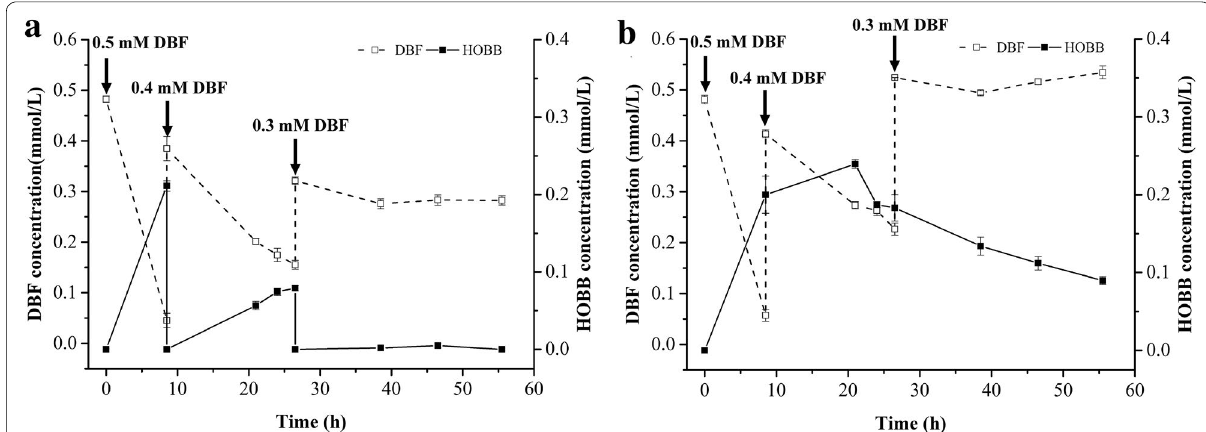
Fig. 5 Biosyntheses of HOBB in batch and fed-batch processes. DBF degradation (open square) and HOBB accumulation (closed square) were evaluated in the two groups. a For the batch group, the biocatalysts were recycled twice, so that there were three sequential batch processes. The initial DBF concentration was 0.5 mM. After DBF was almost completely degraded at 8.5 h, bacteria were recycled by centrifugation and reused for another batch biosynthesis with 0.4-mM DBF. When almost no DBF was degraded, bacteria were reused again for another batch biosynthesis